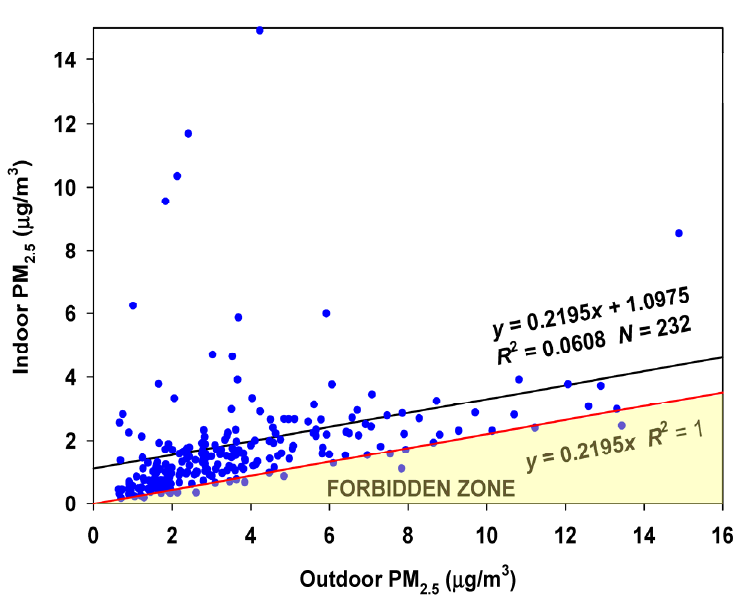
Figure 13. Regression of Oakmont indoor concentrations on Bennett Valley outdoor concentrations for the winter and spring months (December–June (March omitted)). The corresponding regression on the summer–fall months (August–November) again